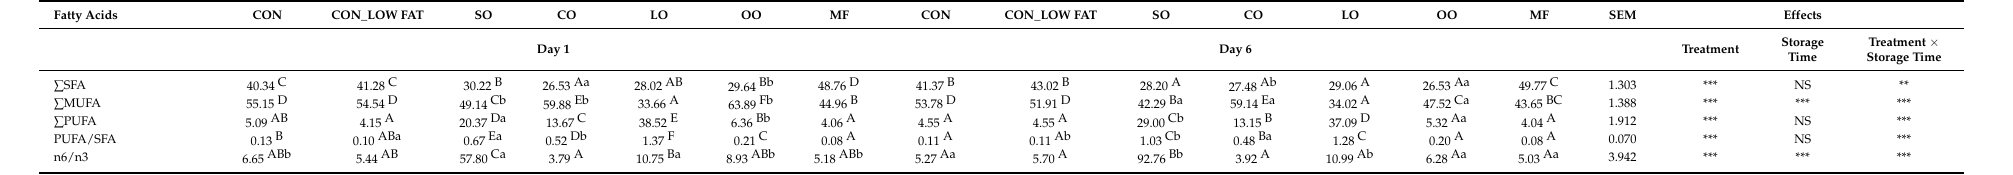
Table 6. The sum of SFA, MUFA, and PUFA burgers on day 1 and day 6 of storage (mean ±